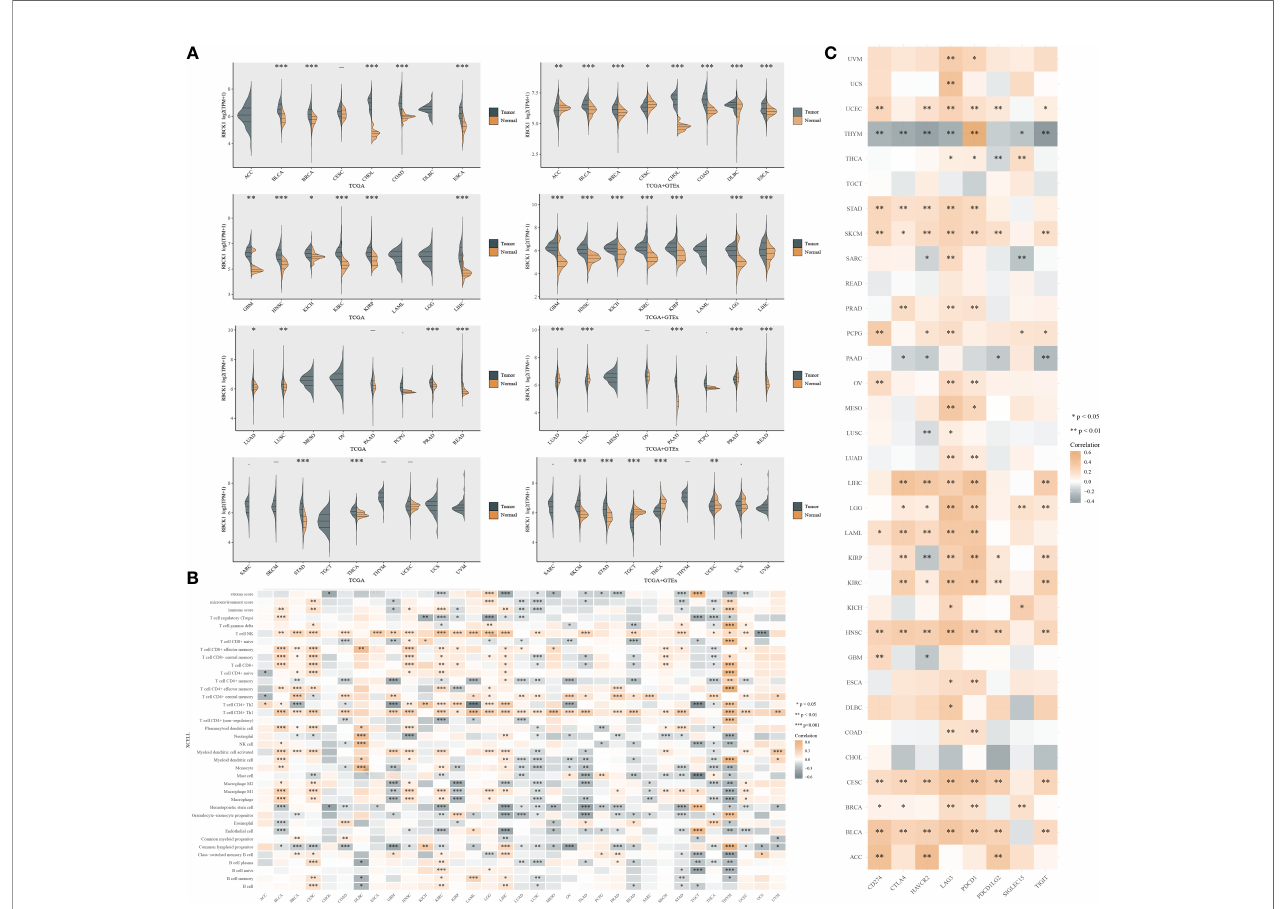
FIGURE 8 | Pan-cancer analysis of RBCK1 mRNA differential expression and correlation analysis of the tumor immune microenvironment. (A) The expression distribution of RBCK1 in tumor and normal samples from the TCGA database and GTEx Portal, where the horizontal axis represents different tumor tissues, and the vertical axis represents the gene expression distribution using the Wilcoxon test (* p < 0.05, ** p < 0.01, *** p < 0.001). (B) Spearman correlation analysis heatmap of immune score and RBCK1 expression in over 13,000 pan-cancer tissues, where the horizontal axis represents different tumor tissues, and the vertical axis represents different immune scores. The stronger the correlation, the darker the color. (C) The heatmap represents the correlation between RBCK1 expression and immune checkpoints (SIGLEC15, IDO1, CD274, HAVCR2, PDCD1, CTLA4, LAG3, and PDCD1LG2) in pan-cancer tissues, where the horizontal axis represents different immune checkpoint genes, and the vertical axis represents different tumor tissues (* p < 0.05, ** p < 0.01, *** p <